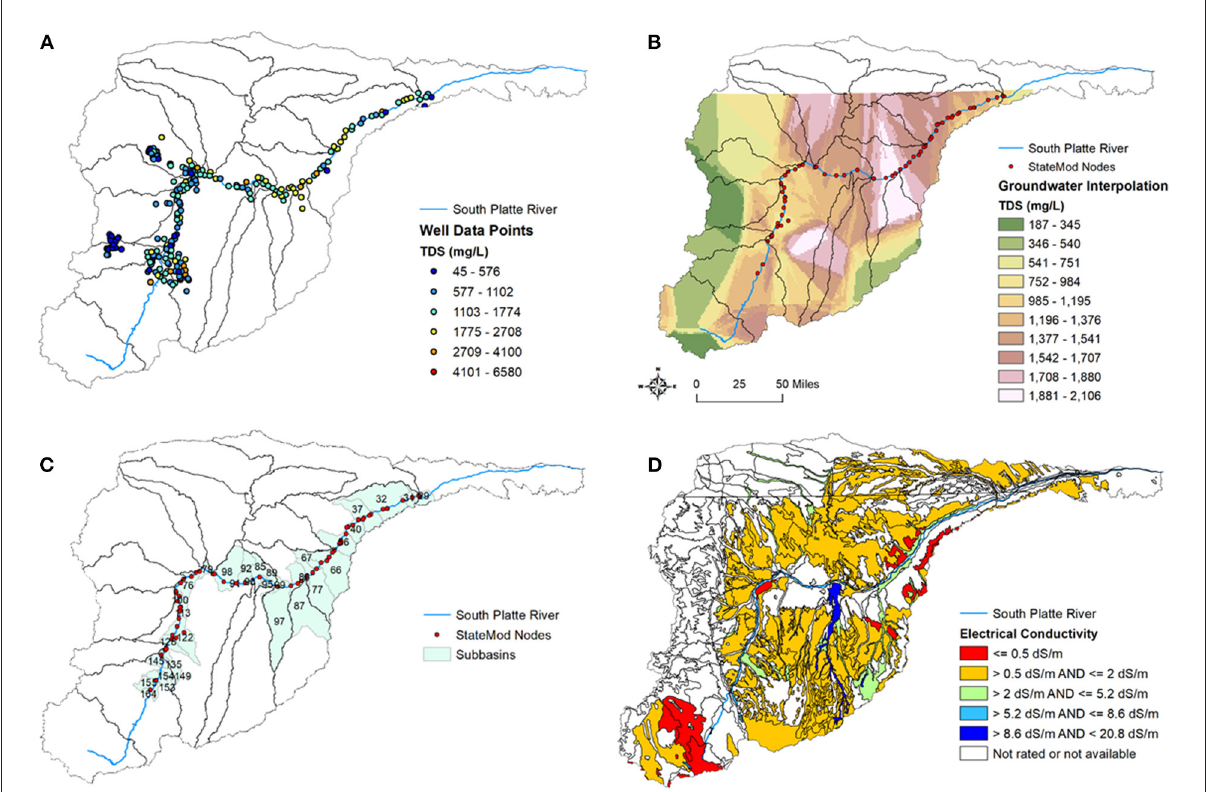
FIGURE5 Maps showing sources and methods of salt inputs into the salt transport model for the South Platte River: (A) locations of groundwater monitoring wells and measured TDS (mg/L), (B) spatially interpolated TDS concentration from the well values, (C) subbasins along the South Platte River, and (D) soil electrical conductivity from NRCS soil maps.